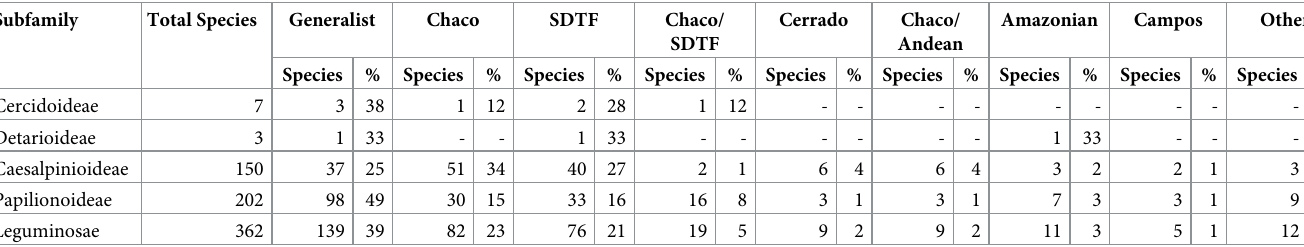
Table 7. Classification of Chaco species according to their lineage. Subfamily Total